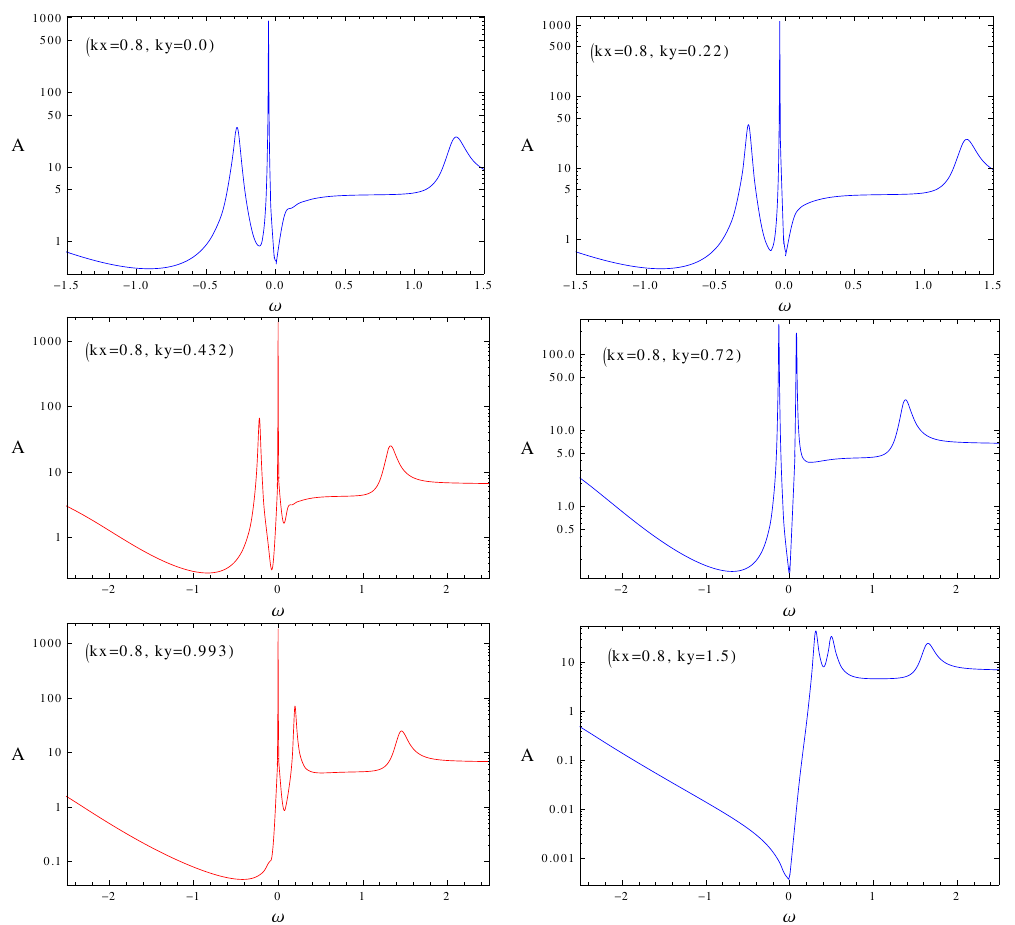
Figure 16 . Behavior of the EDF at di(cid:11)erent points in the momentum plane. We (cid:12)x k x = 0 : 8 and increase k y from points inside the inner Fermi surface to points outside the outer Fermi surface. The two plots in red denote cases in which a Fermi surface is present. Note that the vertical axis is logarithmic. We have used the same setup as in (cid:12)gure